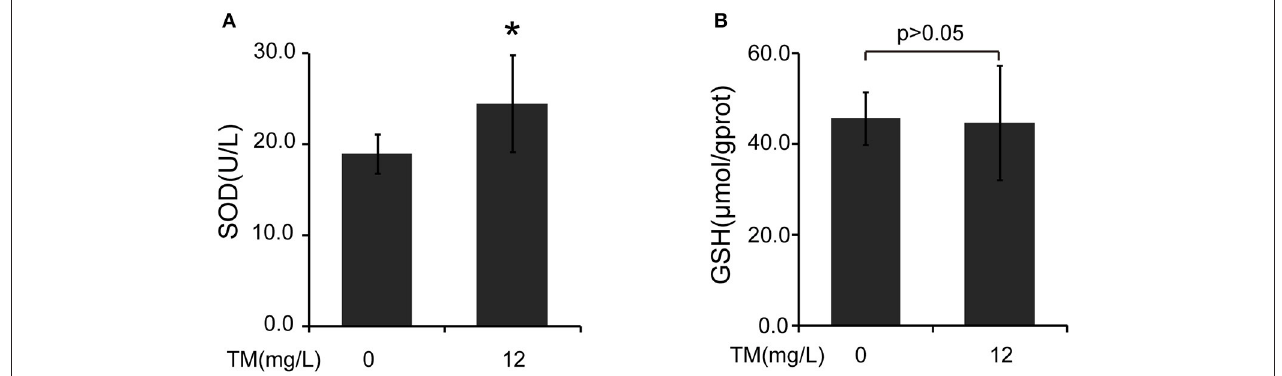
FIGURE 2 | TM induces the activity of SOD in APP/PS1 Tg mouse brains. The brain homogenates were used to analysis the effects of TM. (A) TM increased the activity of SOD compared with control. (B) TM had no effect on the activity of GSH. Data are represented as means ± SD . N = 6 mice per group. * p < 0.05. The p- values were calculated using 2-tailed Student’s t